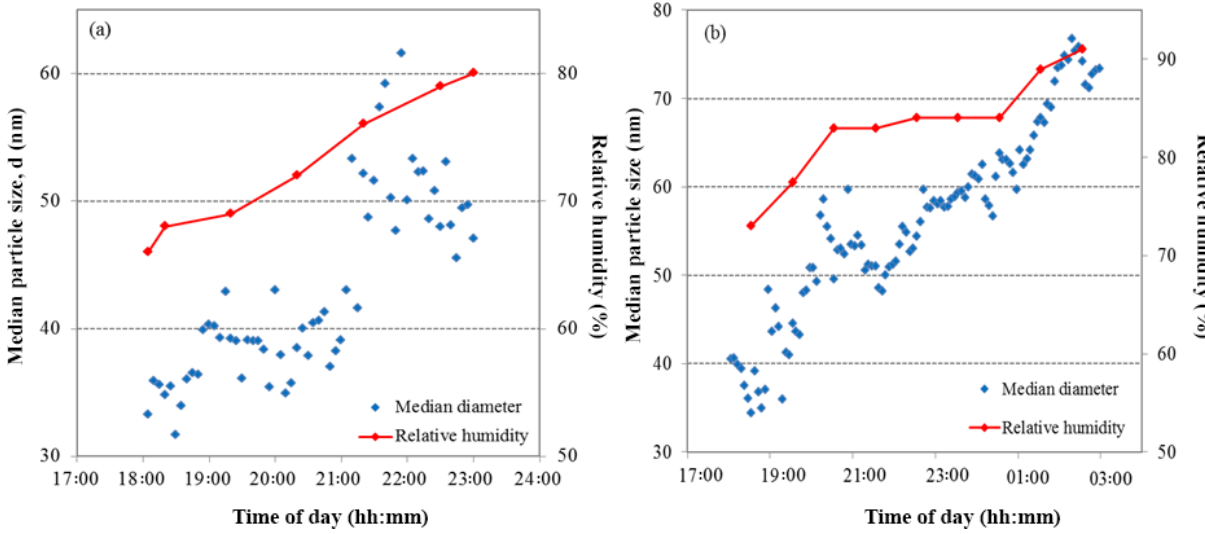
Figure 6. Median particle size and relative humidity as a function of time for growth events on 16 and 20 July 2012,